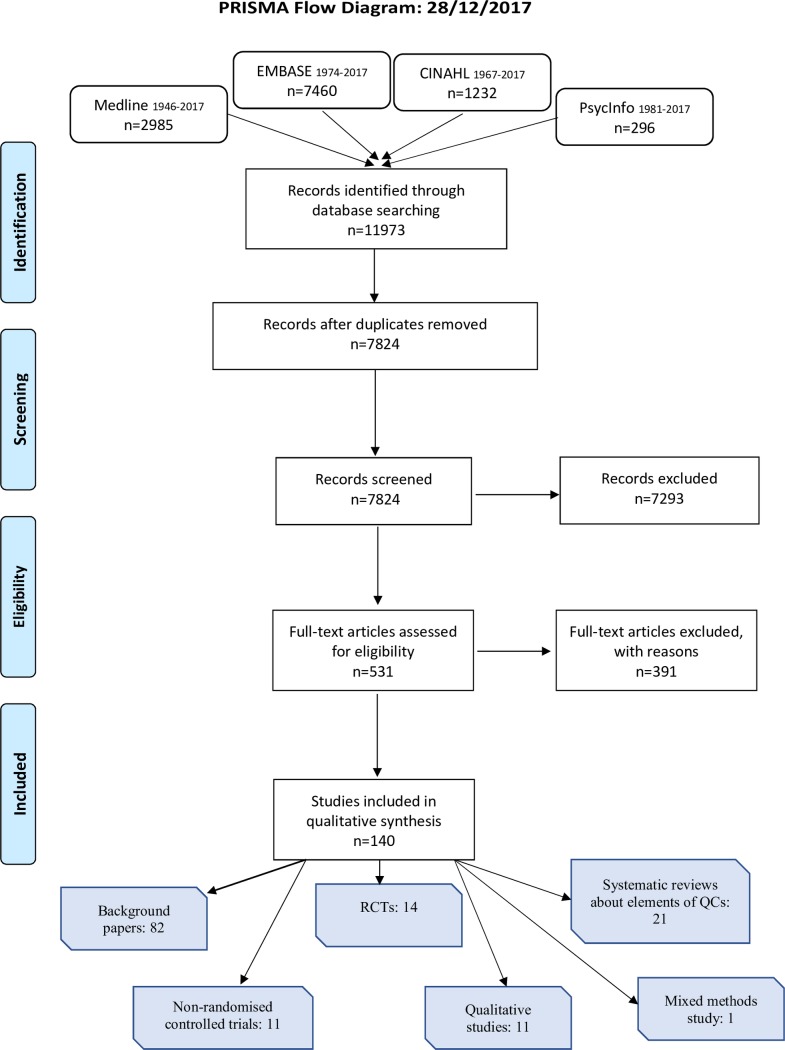
Paper flow diagram.